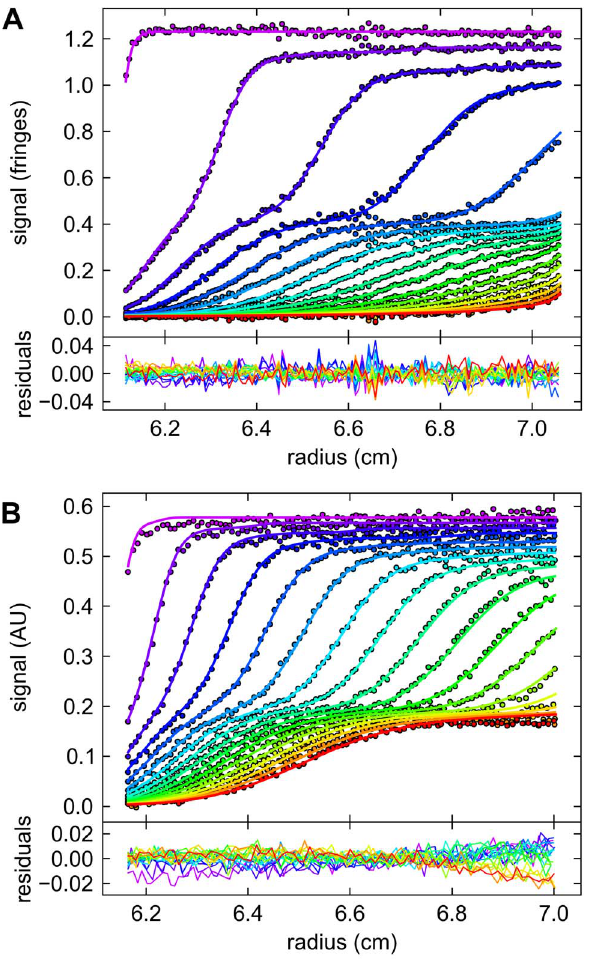
Figure 4. Unconstrained MSSV analysis of the mixture of 6.9 m M Tp34 with 2.3 m M bLF. (A) Interference data (circles), fits (lines) and residuals. Only every 3 rd scan and every 10 th data point used in the analysis are shown. The time-points of the boundaries are indicated in rainbow colors, progressing from purple (early scans) to red (late scans). (B) Absorbance data, fits, and residuals, showing every 3 rd scan and every 4 th data point. The best-fit c k ( s ) distributions are shown in Fig. 5A.